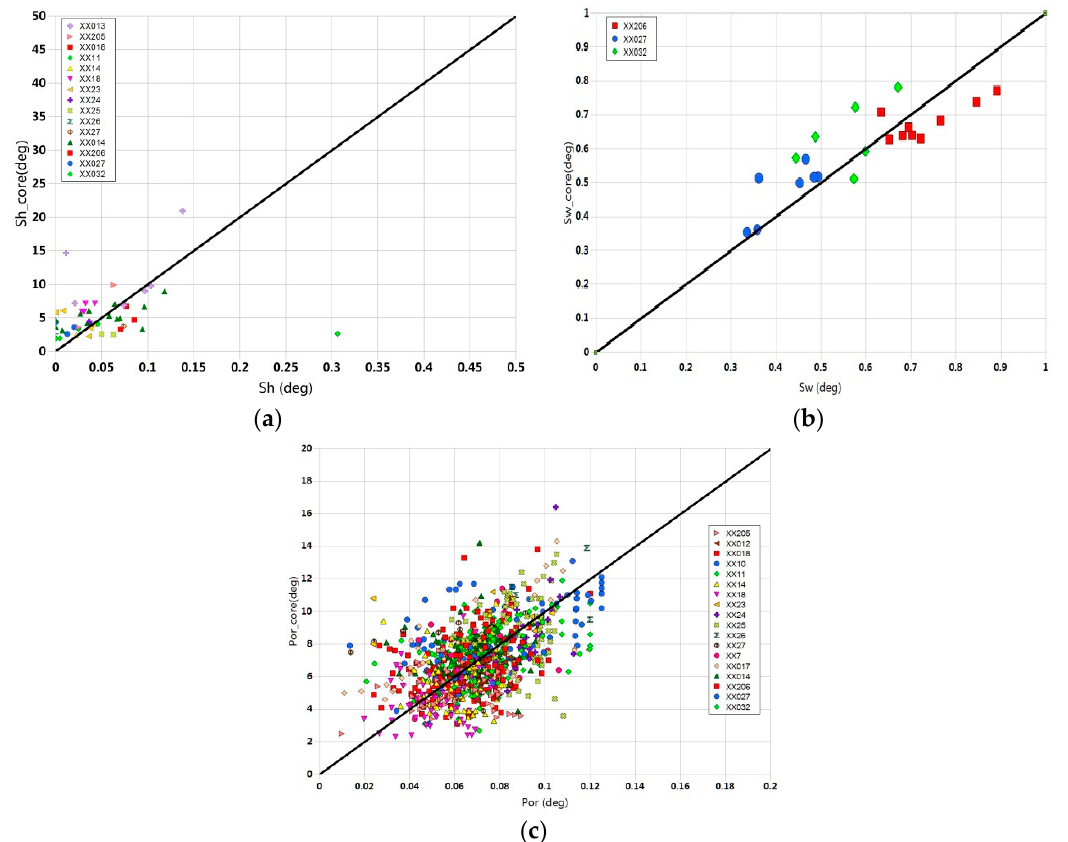
Figure 10. Comparisons between logging interpretation results and core analysis results: ( a ) clay content; ( b ) water saturation; ( c ) porosity.